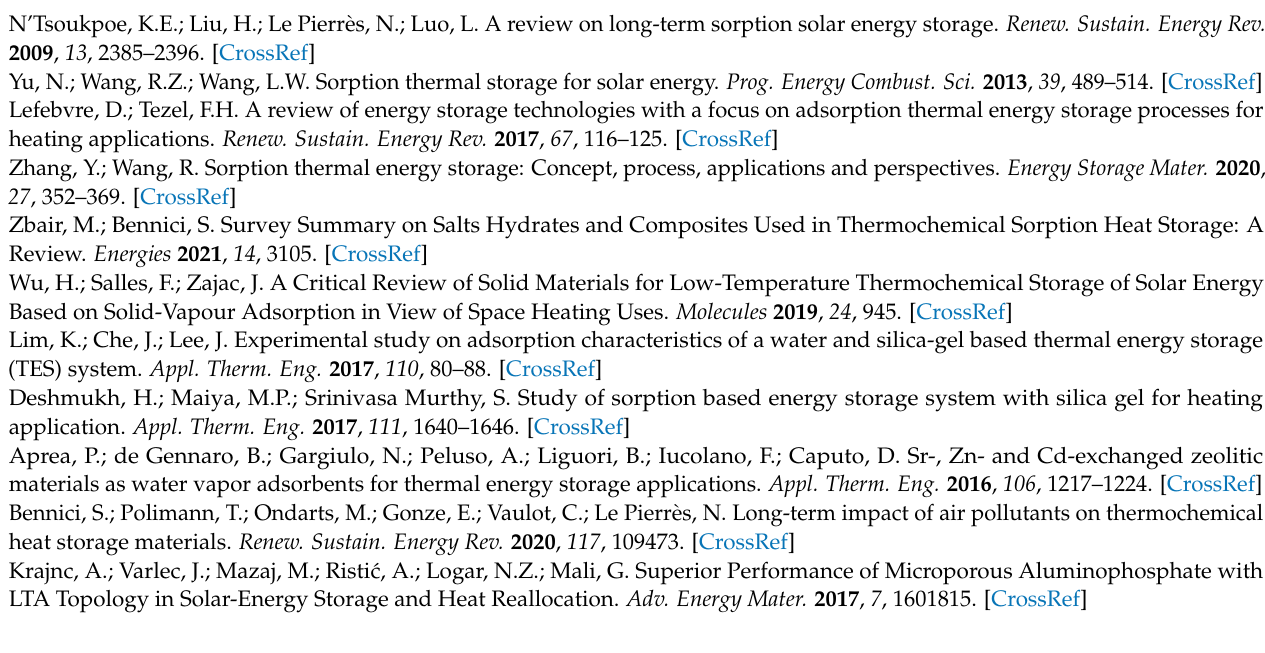
system, Figure S2: experimental equipment based on flow calorimetry system, Figure S3: homemade laboratory-scale test rig, Figure S4: XRD patterns of zeolite samples, Figure S5, Table S1: XPS study of Ce-13X, Figure S6: XRD pattern and FTIR spectrum of PBA, Figure S7: thermogravimetric analysis and differential scanning calorimetry study of PBA, Figure S8: adsorption of gaseous nitrogen at 77 K, Figure S9: preservation of structural integrity of adsorbents during charging–discharging cycles, Figure S10: importance of the cooling step on the thermal performance of adsorbents, Figures S11–S15: heat release